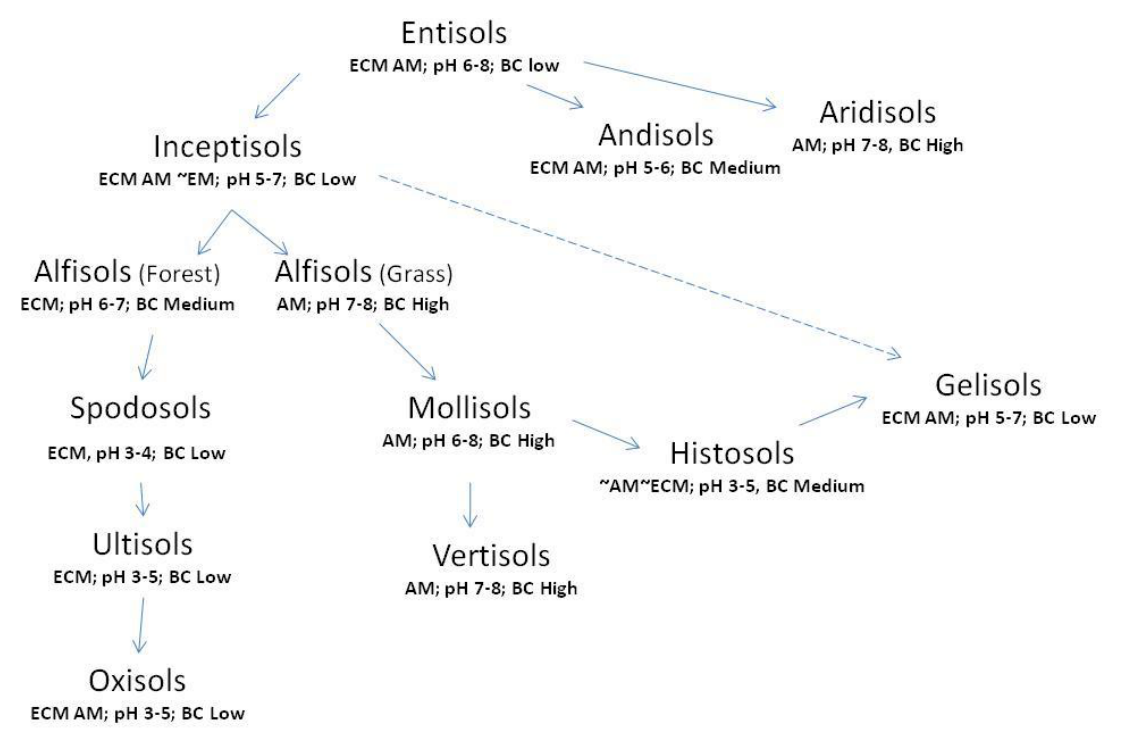
Figure 4. Soil world taxonomic orders (according to the US Taxonomy [307]) and principal mycorrhizal associations that inhabit those orders. Also shown is the pH range of a typic soil of each order and the buffering capacity (BC) of each. Some mycorrhizal associations are shown but prefixed by ~, meaning these are present but at low levels or restricted. The arrows in this figure show general soil evolution.. This evolutionary sequence is imperfect in that often soils reach an endpoint in development that only will be passed if there is a massive change in, for example, climate. In other cases, a particular soil will only develop if there is a particular geological substrate